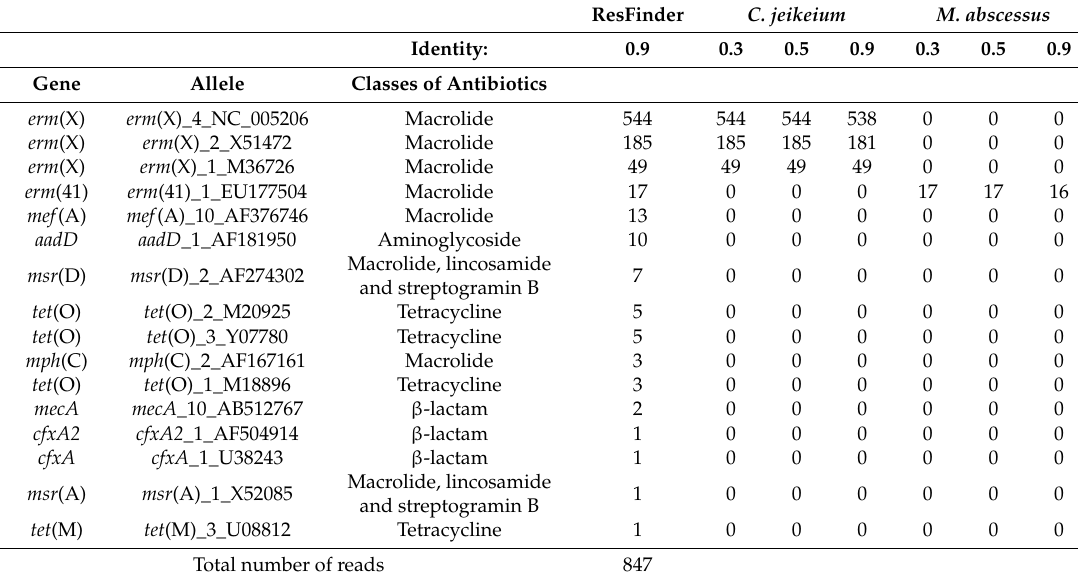
Table 4. Number of sequencing reads mapped to ResFinder database and genomic reference sequences of C. jeikeium and M. abscessus